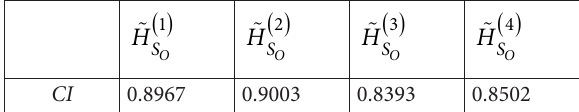
Table 4. The correlation coefficients and consensus degrees of